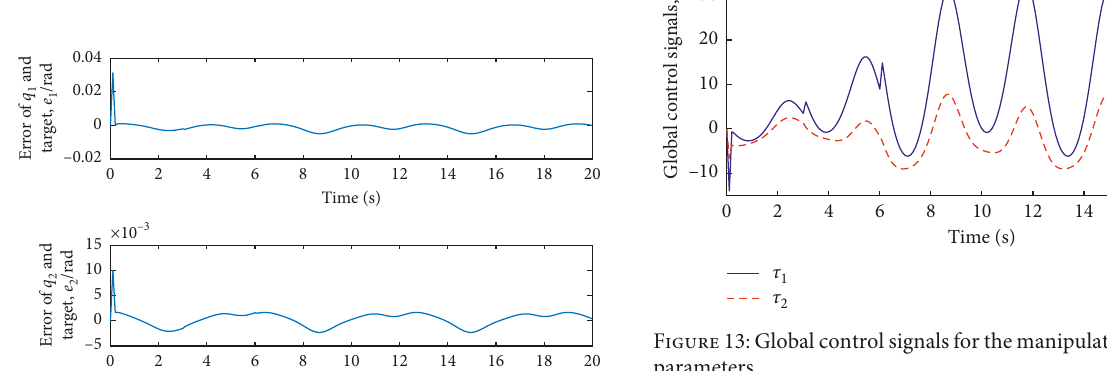
Figure 10: Tracking performance of q